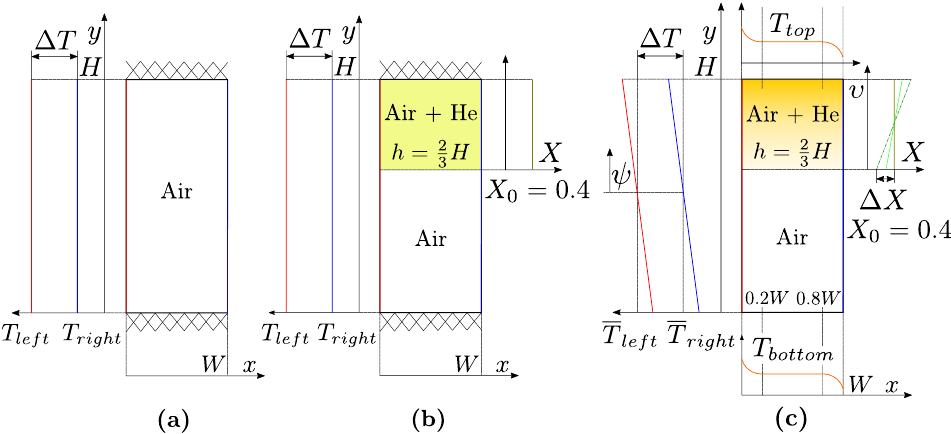
Figure 4. Investigated configurations of the Differentially Heated Cavity (DHC) with aspect ratio 4: ( a ) default case, ( b ) reference case, and ( c ) parameter variation